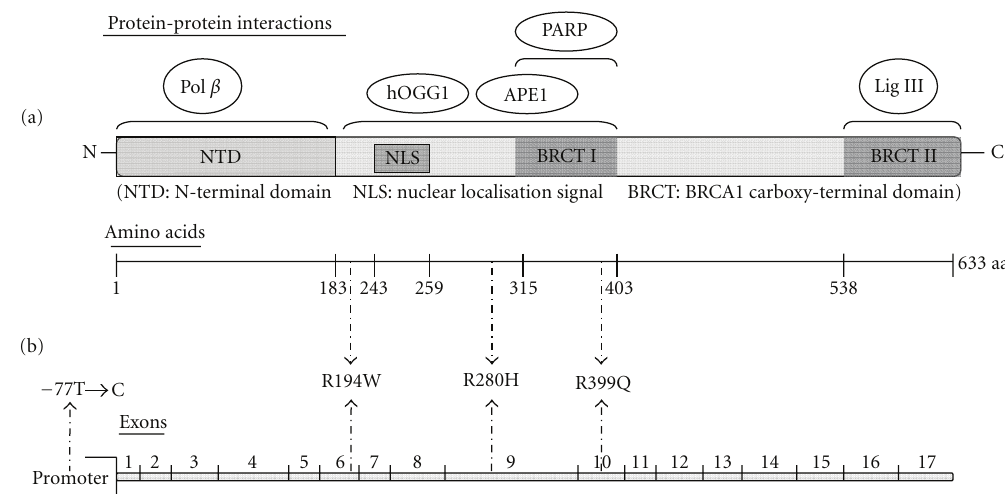
Figure 1: Human XRCC1 protein and gene structure. (a) The diagram shows XRCC1 domains and the regions of interaction with other components of BER. (b) The diagram shows the structure of the gene with the most common and studied single nucleotide polymorphisms (SNPs): − 77 T → C, R194W, R280H and R399Q. Each of them is detailed in the